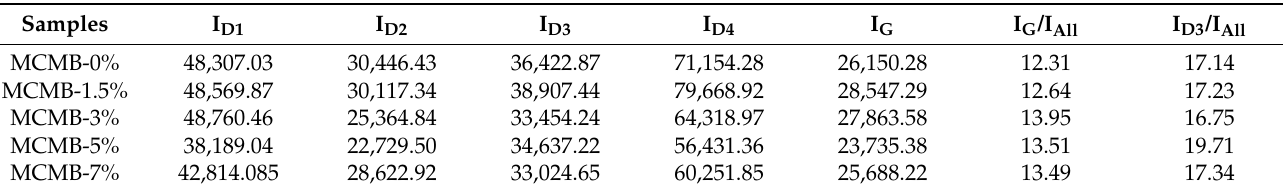
Table 4. The distribution of carbon microcrystalline in MCMBs.